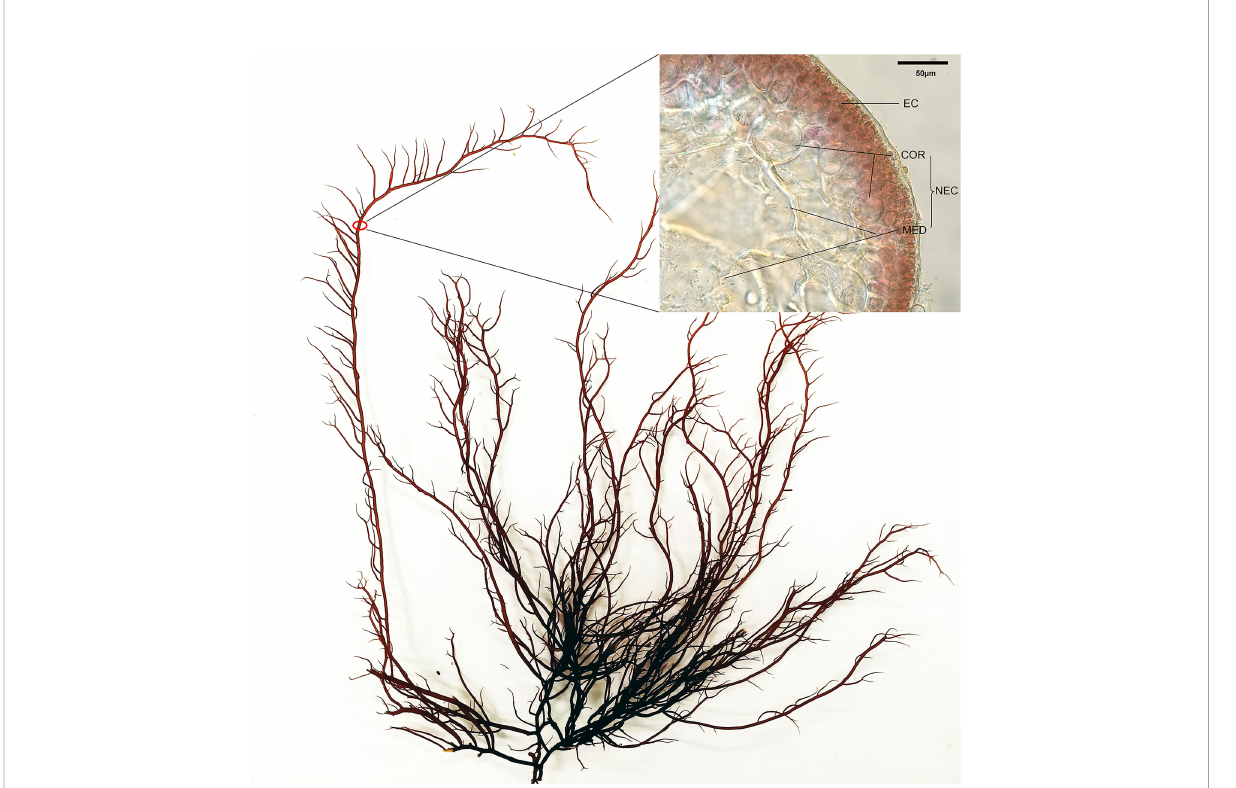
FIGURE 1 Alga and the cells in the branch of G. lemaneiformis , EC, epidermal cell; NEC, non-epidermal cell; COR, cortical cell; MED, medullary